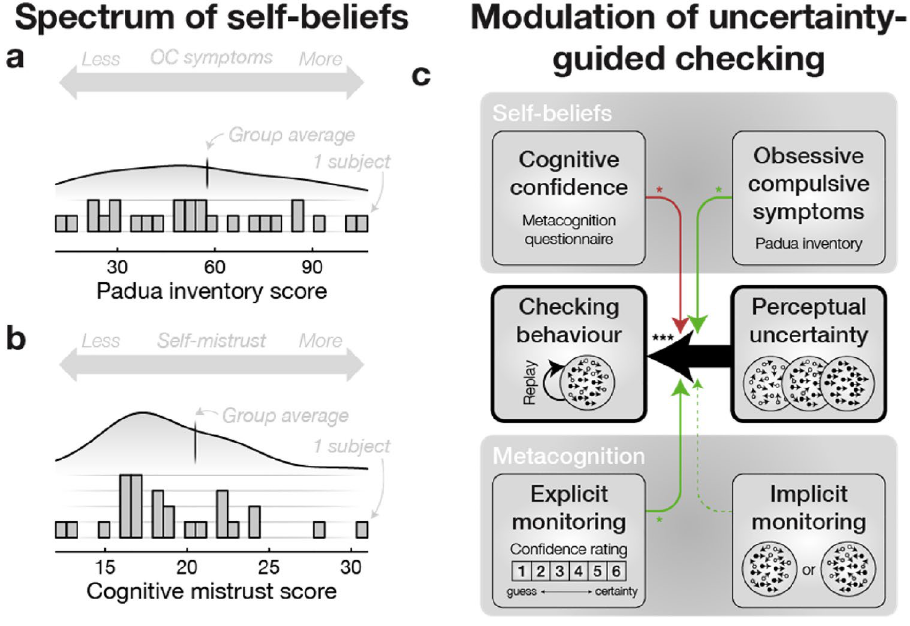
Figure 3. Modulation of checking uncertainty-guided behavior. ( a / b ) Distribution of participants on the Padua inventory/cognitive mistrust subscales . Participants spread over a large spectrum of self-beliefs, which replicated previous findings 28,36,37 (see Methods). ( c ) ℳodulation of uncertainty-guided checking . Arrow size are proportional to z -scores from the Poisson model of the number of checks ( ℳ 1 , see Methods). Arrow color denotes the direction of the effect (green: positive, red: negative). Stars indicate significance: * P < 0.05, ** P < 0.01, and *** P <